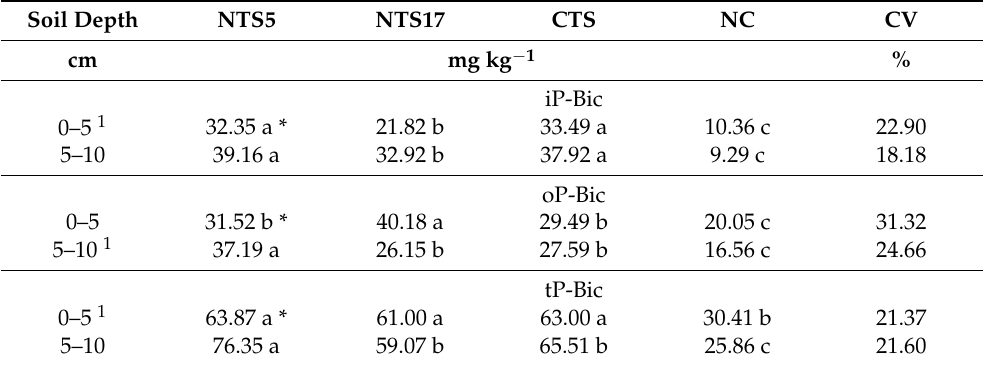
Table 4. Labile portions of inorganic P (iP-Bic), organic (oP-Bic), and total (tP-Bic) of soil extracted with sodium bicarbonate (NaHCO 3 ) in the different management